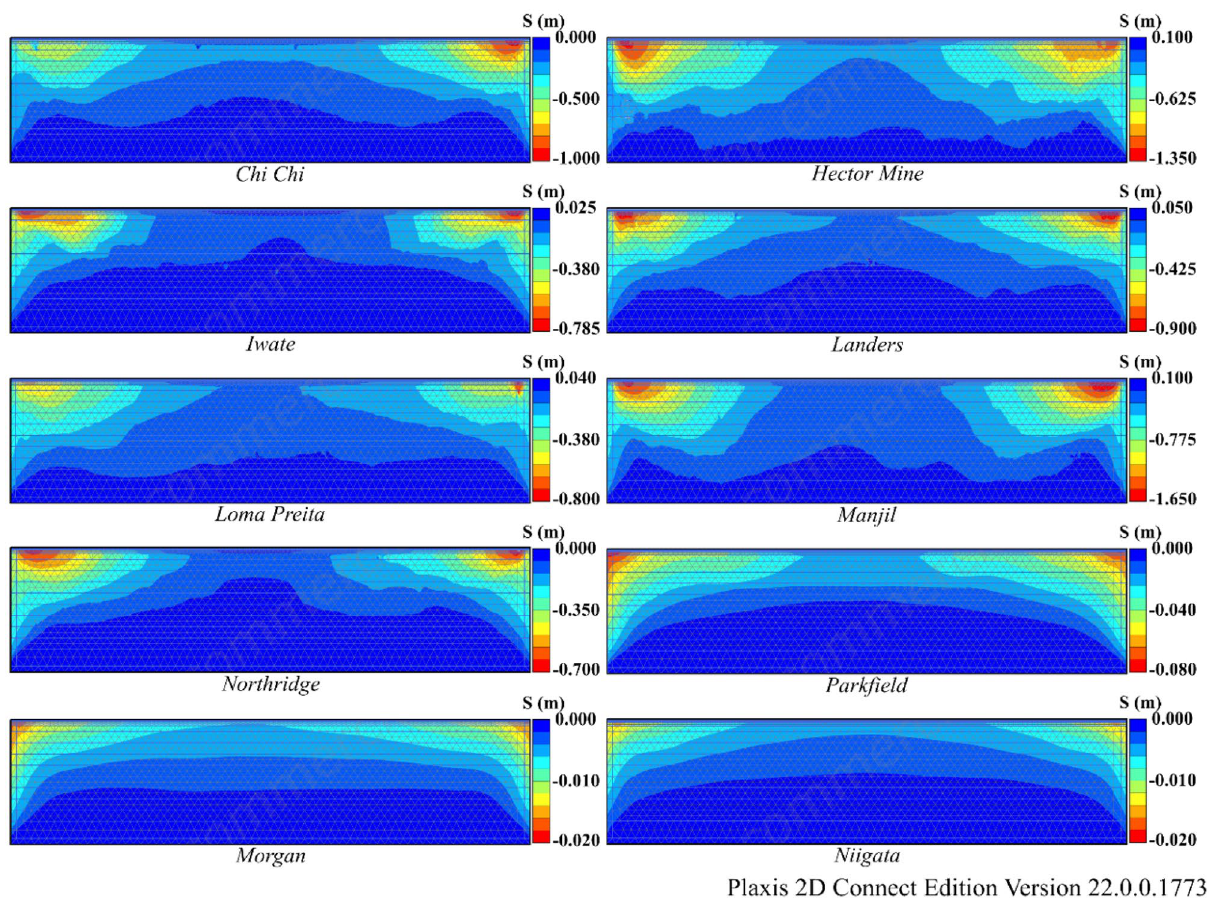
Figure 16. Liquefaction-induced settlement results for Model